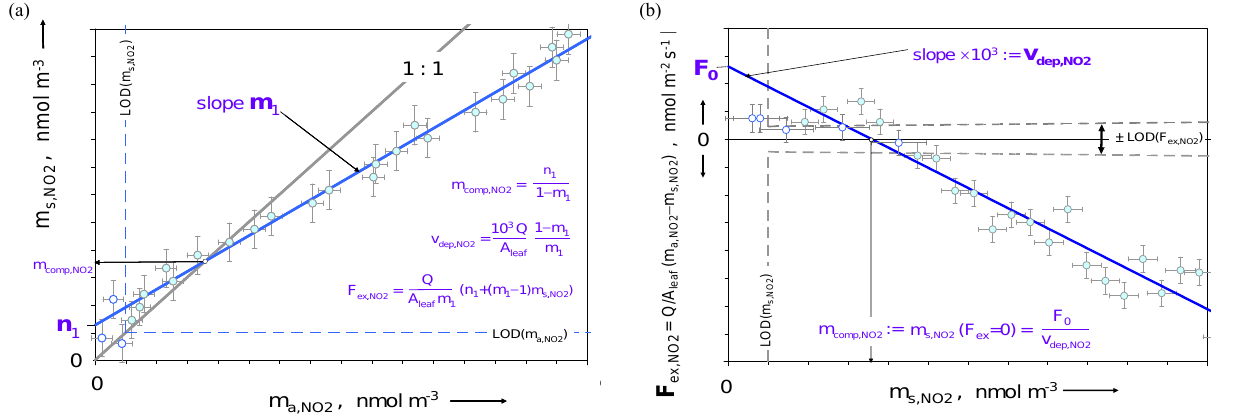
), NO 2 deposition velocity 2 with m a,NO . 2 2 , 2